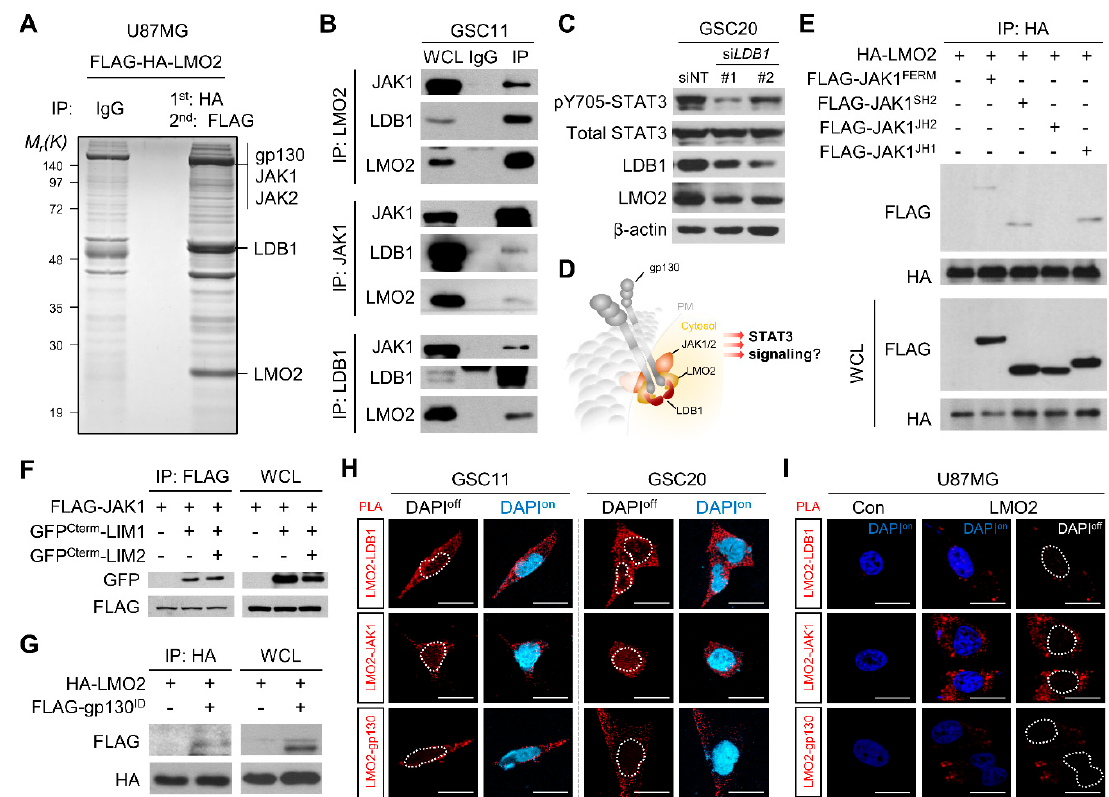
Figure 2. The LMO2-LDB1 Complex Regulates STAT3 Activity via Interaction with gp130 and JAKs. ( A ). Coomassie Brilliant Blue staining of affinity-purified protein from HA-FLAG-LMO2-expressing U87MG cells. LMO2-interacting protein bands were analyzed by LC-MS/MS. ( B ). Co-immunopre- cipitation (Co-IP) of LMO2, JAK1, and gp130 in GSC11 cells IgG is the control antibody for Co-IP. Whole cell lysates (WCLs, lane 1) or immunoprecipitates generated with the indicated antibodies (lane 3) or a control IgG antibody (lane 2) were immunoblotted with the indicated antibodies. ( C ). Cell lysates of GSC20 cells transfected with either non-target siRNA or si LDB1 were immunoblotted with antibodies specific for pY705-pSTAT3, total STAT3, LDB1, LMO2, and β -actin. ( D ).A schematic diagram showing that LMO2 binds to LDB1, JAK1/2, and gp130. ( E ). A Co-IP experiment to identify the LMO2-interacting JAK1 domains (FERM, SH2, JH2, and JH1) in HEK293FT cells. HEK293FT cells were transfected with expression vectors encoding FLAG-JAK1 FERM , FLAG- JAK1 SH2 , FLAG- JAK1 JH1 , and FLAG-JAK1 JH2 together with HA-LMO2. The cell lysates were immunoprecipitated with an antibody against HA captured with agarose A/G beads and blotted using anti-FLAG and anti-HA antibodies. The expression levels were checked using 40 μ g of WCLs and immunoblotted with the indicated antibodies. ( F ). A Co-IP experiment to identify the LMO2 domains that bind to JAK1 proteins in HEK293FT cells. HEK293FT cells were transfected with expression vectors encod- ing GFP Cterm -LIM1 or GFP Cterm -LIM2 together with FLAG-JAK1 (GFP Cterm means GFP-encoding DNA sequence is fused with the C-terminus region of the gene of interest). The cell lysates were immuno- precipitated with an antibody against FLAG captured with agarose A/G beads and blotted using anti-GFP and anti-FLAG antibodies. The expression levels were checked using 40 μ g of WCLs and immunoblotted with the indicated antibodies. ( G ). A Co-IP experiment was performed to identify whether the gp130 intracellular domains (ID) interact with LMO2 in HEK293FT cells. HEK293FT